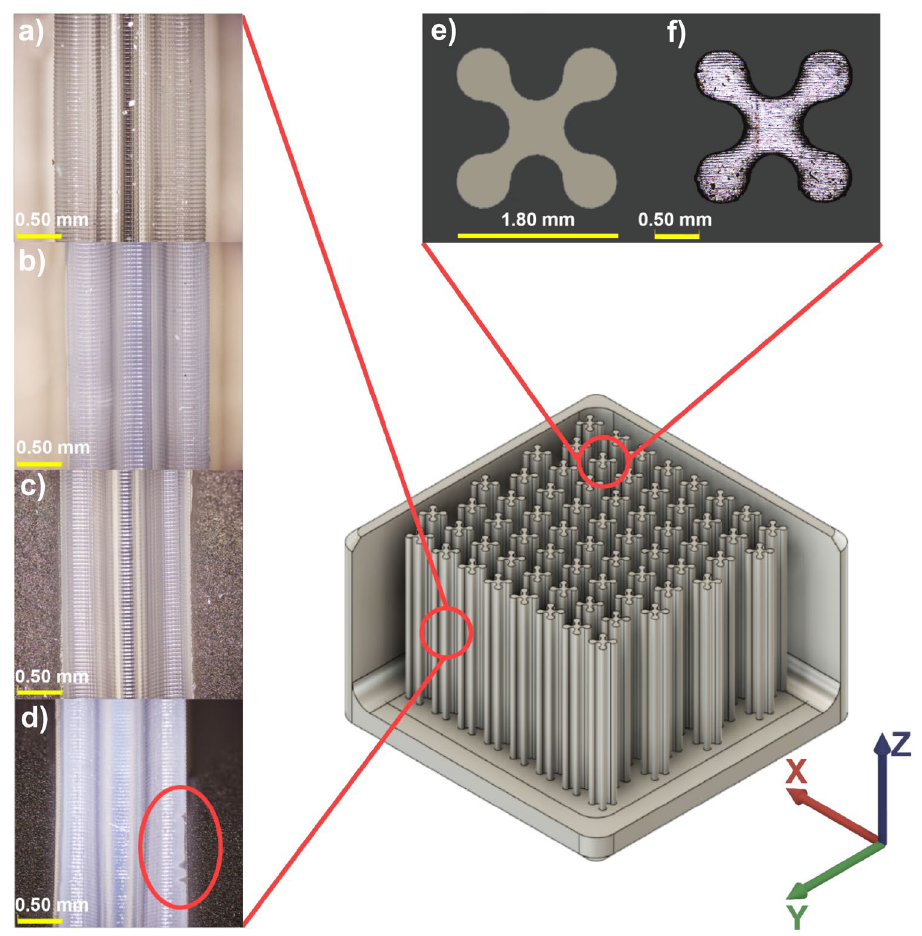
Figure 4. Confocal pictures of the printed stack layer (Z-axis) of the micro-reactor prototype printed from different resins; ( a ) STD, ( b ) STDPPG430, ( c ) STDPPG1030, and ( d ) STDPPG2030, and the printed layer (XY-planar); ( e ) designed pattern and ( f ) 3D printed